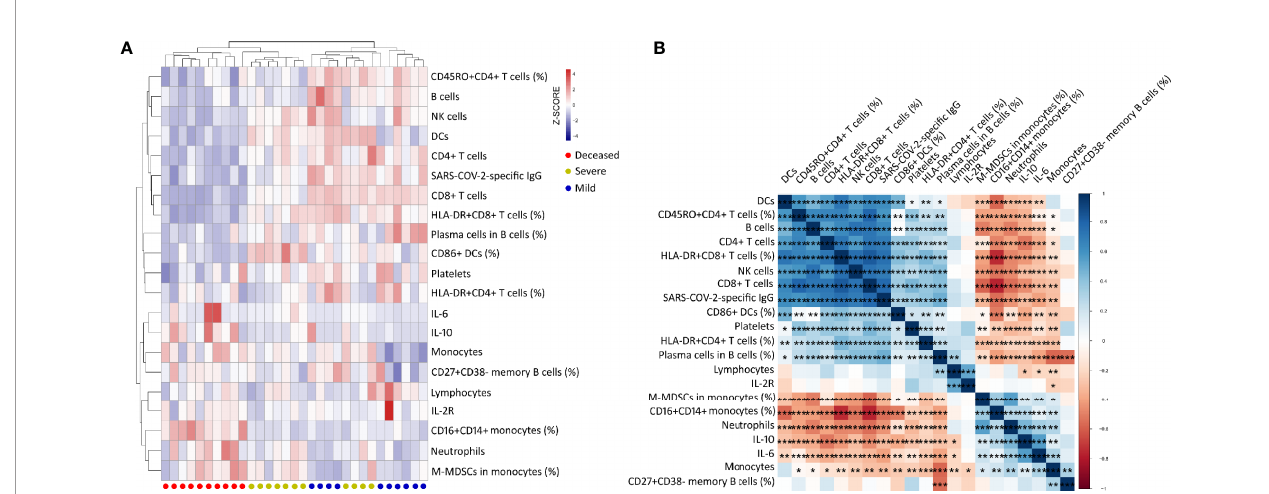
FIGURE 4 | Clustering analysis of immune parameters in COVID-19 patients with different outcomes on day 9 after onset of illness. (A) Heat maps comparing 21 immune parameters in mild (n = 10), severe (n = 11), and deceased (n = 10) patients. On the y-axis are immune parameter values after z-scoring, and on the x-axis are individual patients. Red – white – blue squares represent z-scoring values. Red dot, deceased patient; yellow dot, severe patient; blue dot, mild patient. (B) Correlation matrix of 21 immune parameters in 31 COVID-19 patients (mild, n = 10; severe, n = 11; deceased, n = 10). M-MDSCs, monocytic-myeloid-derived suppressor cells; IL-2R, IL-2 receptor; lymphoid-derived DCs, dendritic cells. * p < 0.05, ** p < 0.01, *** p < 0.001.